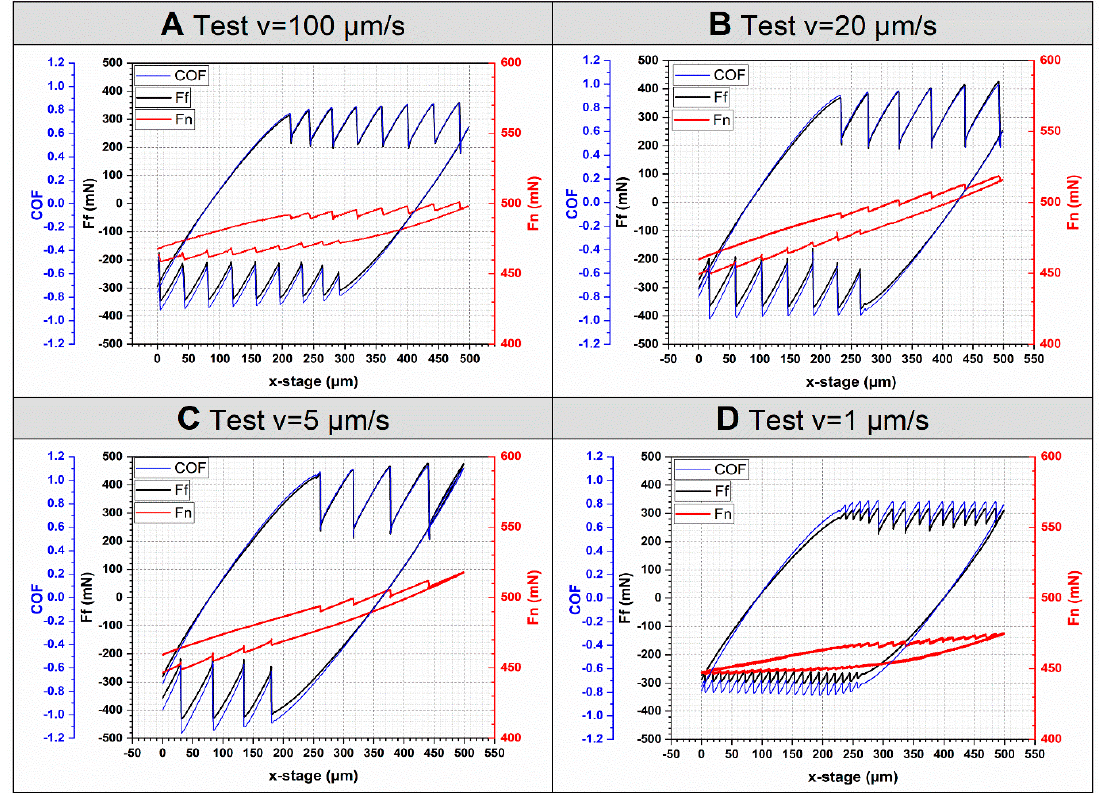
Figure 5. Comparison of the first cycle in four tests. Data shown is the coefficient of friction (blue), friction force (black), and normal force (red From A to D , the test speed is 100 µm/s, 20 µm/s, 5 µm/s and 1 µm/s, respectively.